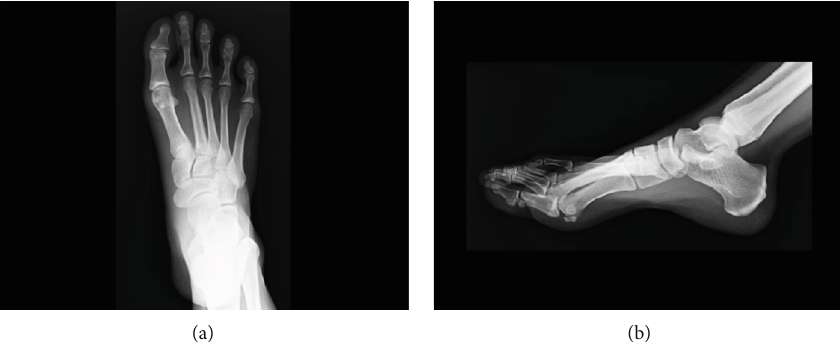
Figure 1: Preoperative foot radiograph at an initial visit to our institution. An oblique fracture line at the base of the second metatarsal was identi fi ed on (a) anteroposterior and (b) lateral views.